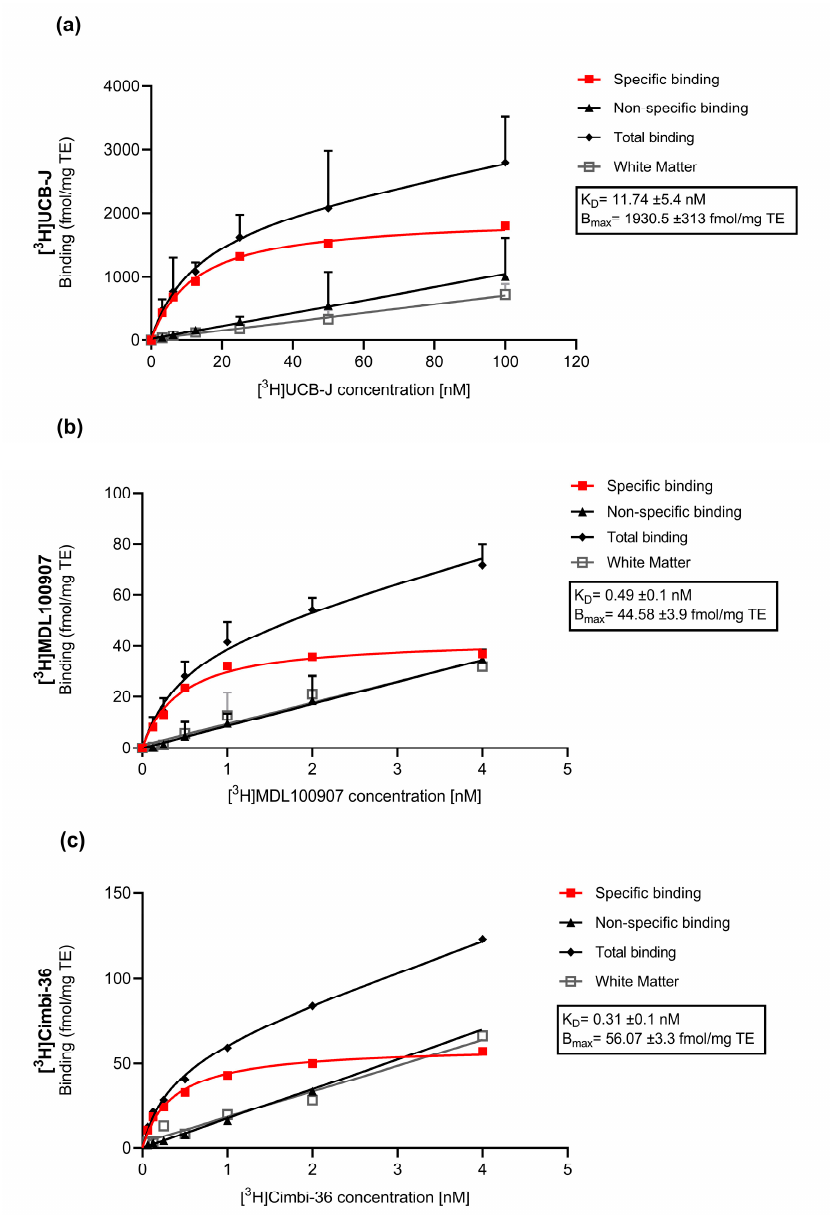
Figure A1. Saturation assay of [ 3 H]UCB-J ( a ), [ 3 H]MDL100907 ( b ) and [ 3 H]Cimbi-36 ( c ) in the grey matter of the pig